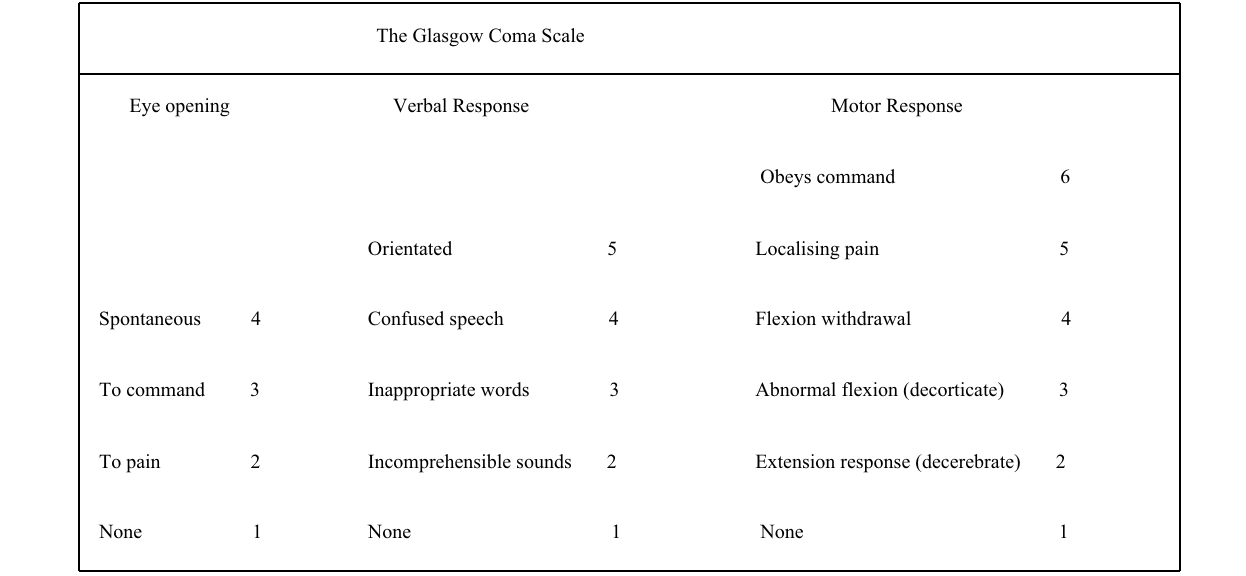
4-item BEO part of the scale and worst for the 6-item BMR